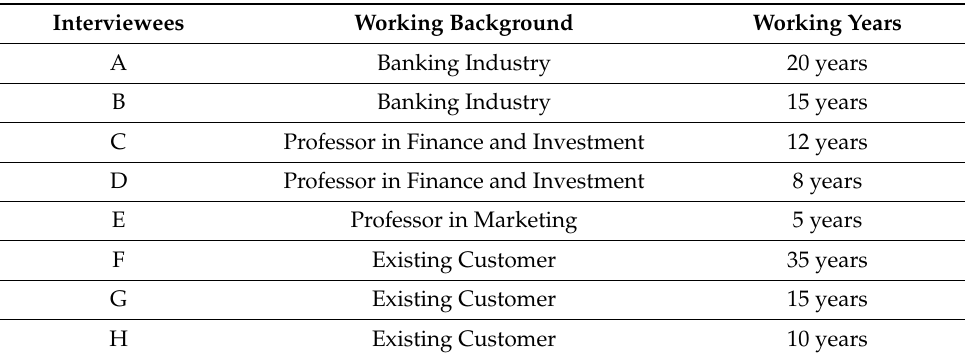
Table 1. Major suggestions for the evaluation framework from expert interviews.